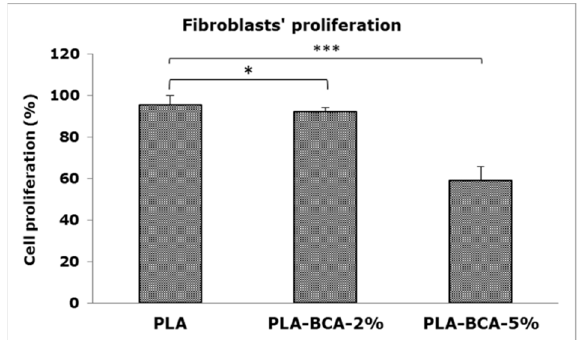
Figure 7. Results of MTT test showing the effect of examined electrospun PLA fibers with 2% and 5% BCA and without BCA on proliferation of L929 fibroblasts; (*) p < 0.05, (***) p < 0.001.